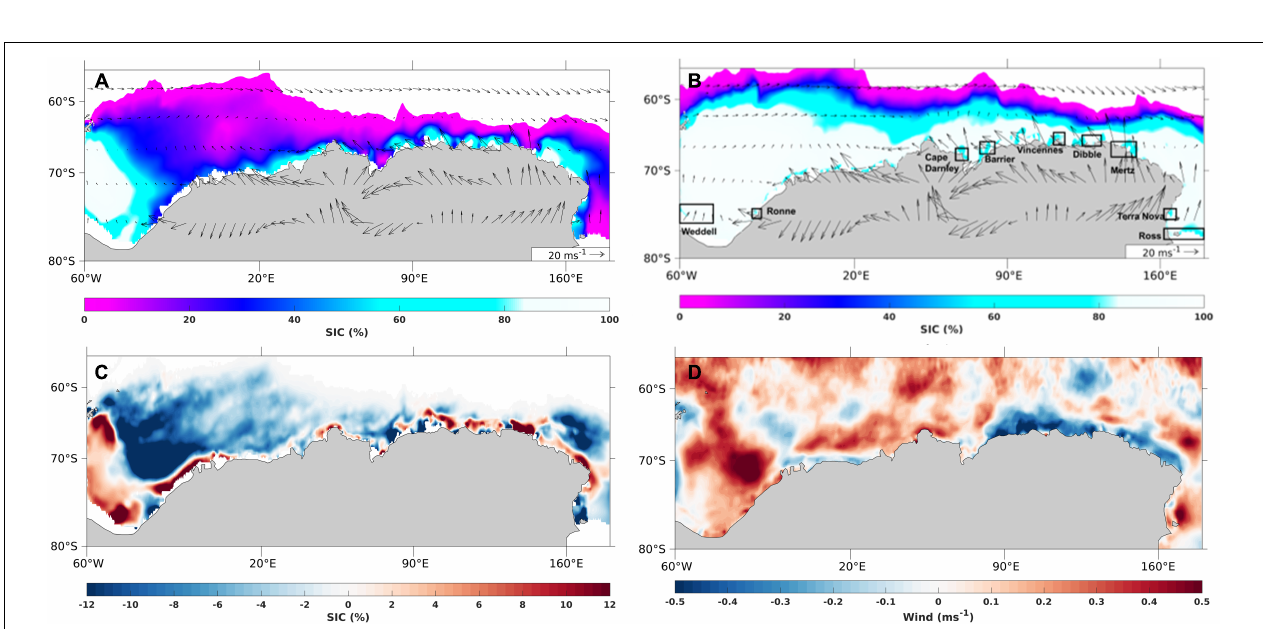
FIGURE 3 | (A) The thickness of the Antarctic Bottom Water (AABW) in the Indian sector of the Southern Ocean (ISSO), (B,C) Vertical distribution of temperature along a meridional section (between 68 and 75 ◦ E) showing the propagation of warm Circumpolar Deep Water (CDW) toward the shelf region of the Prydz Bay during (B) 2017, (C) 2018 (Neutral density > 28.05 Kg m - 3 has used to demarcate the CDW) and (D) TS diagram depicts the CDW variability for the period 2015–2017 off Cape Darnley region from the seal data.